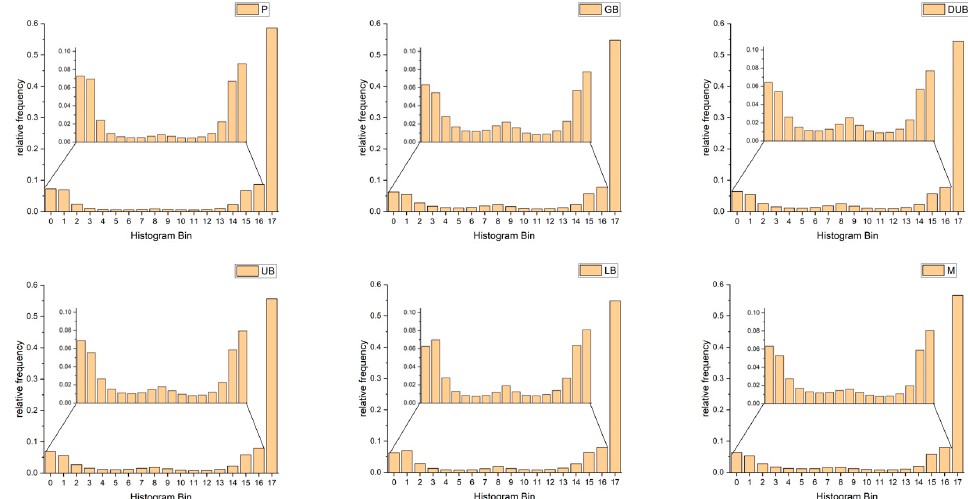
Figure 12. Averaged histograms of LBP with R = 4.2 and N = 16 of all images for all six microstructure classes. Averaging performed by calculating the mean value of the separate bins for every analyzed image. Bins 0–16 are also shown enlarged.